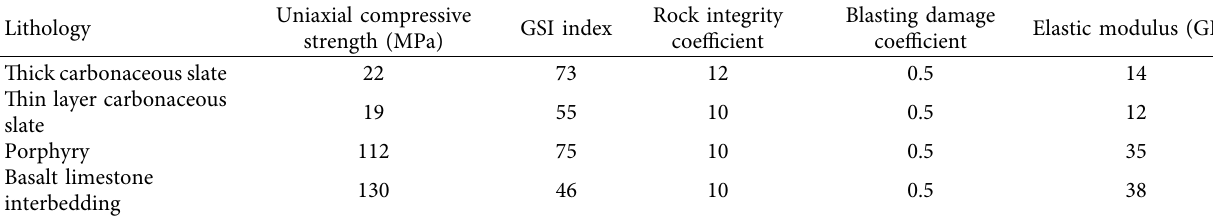
Table 1: Rock block